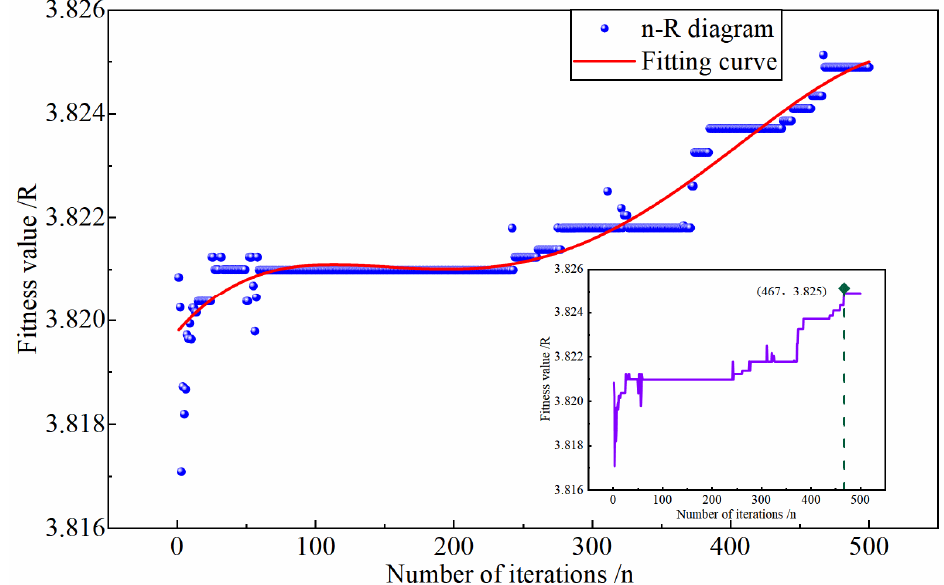
Figure 8. The fitted curve of the number of iterations of the IGA (n) to strength ratio (R). The expression of the red curve in Figure 8 is given below as,